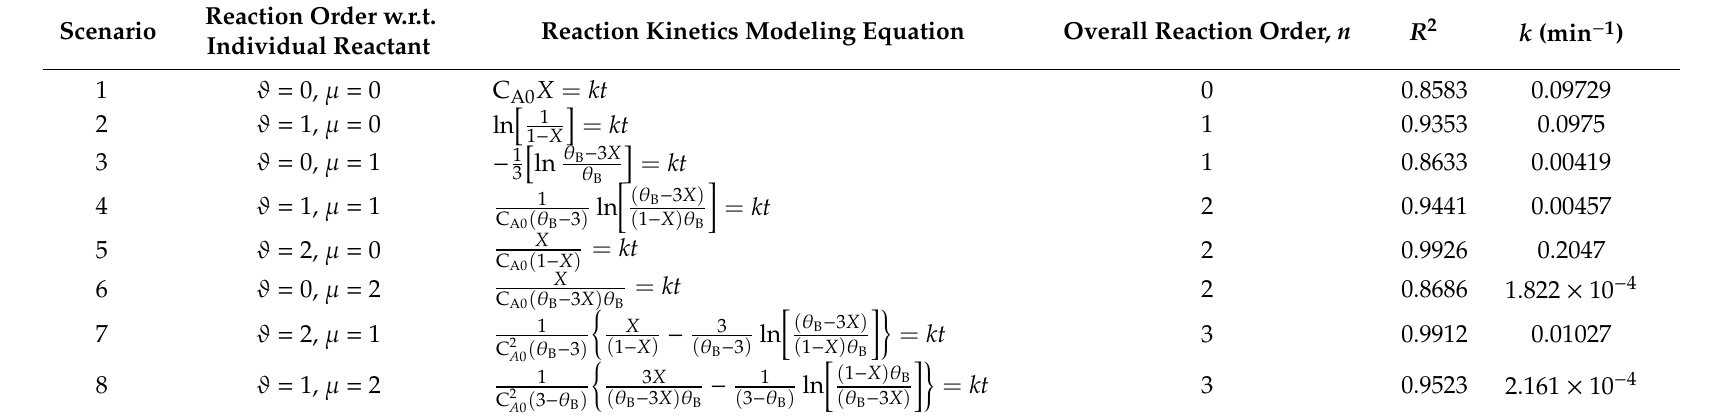
Table 6. Transesterification kinetics modeling and